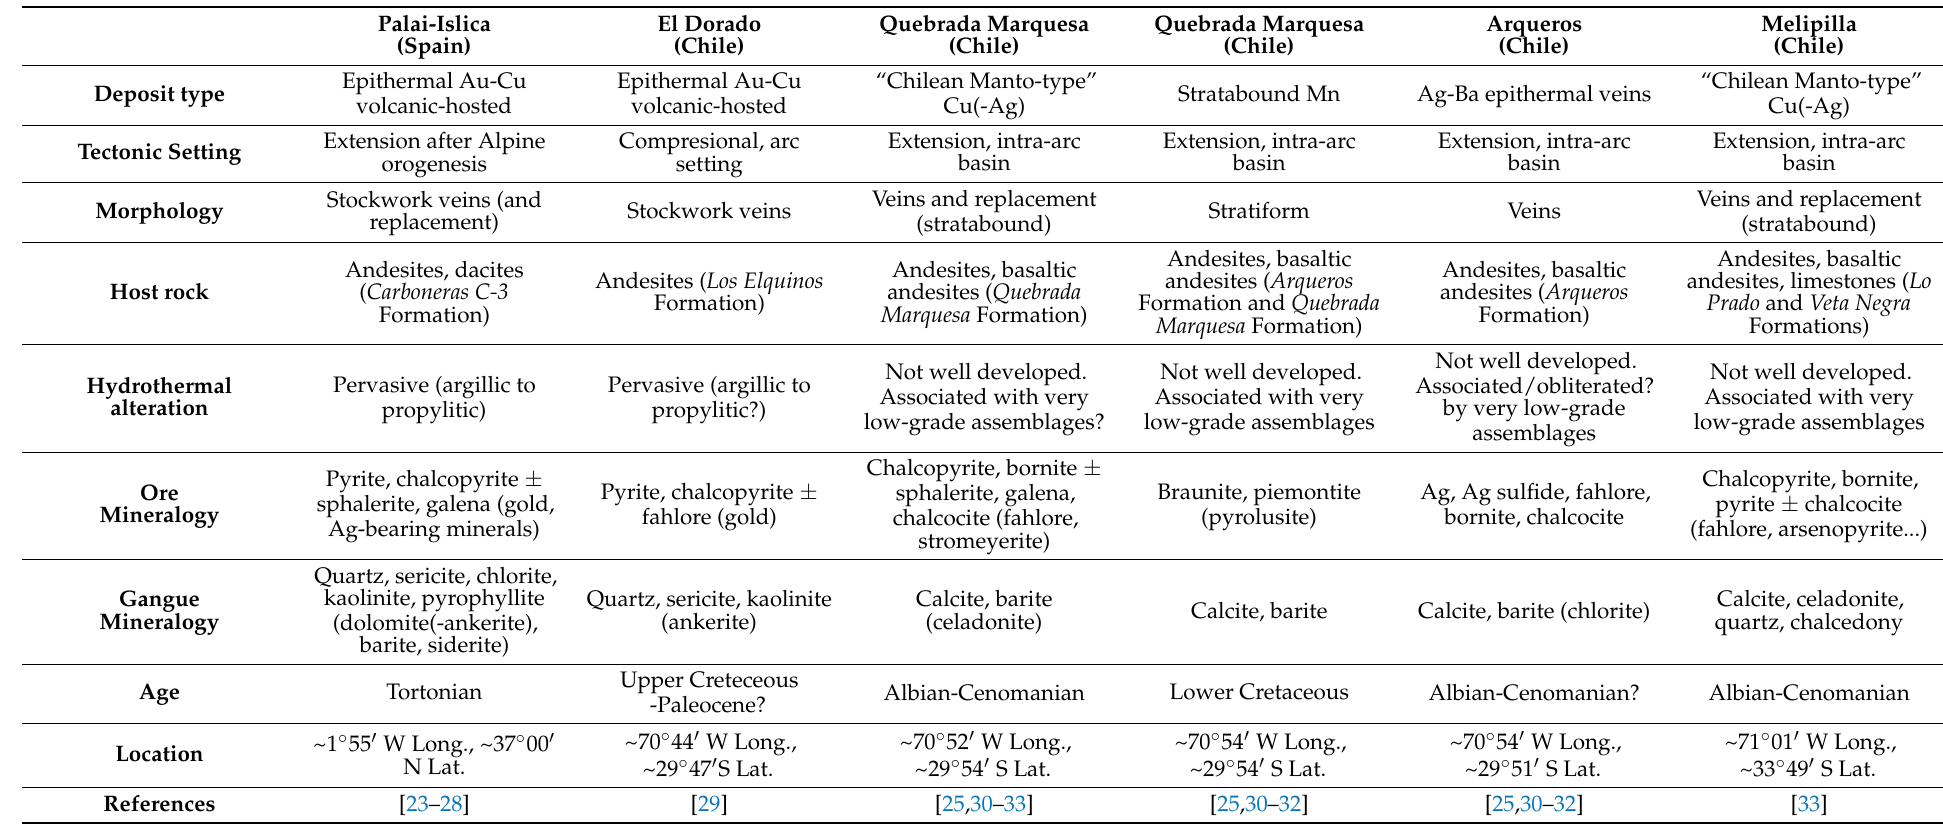
Table 1. Summary of the main characteristics of the mineral deposits that hosts the studied